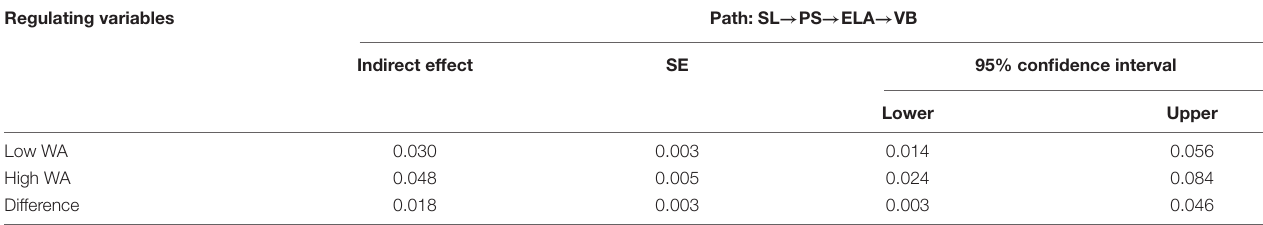
TABLE 5 | Test results of regulated chain mediating